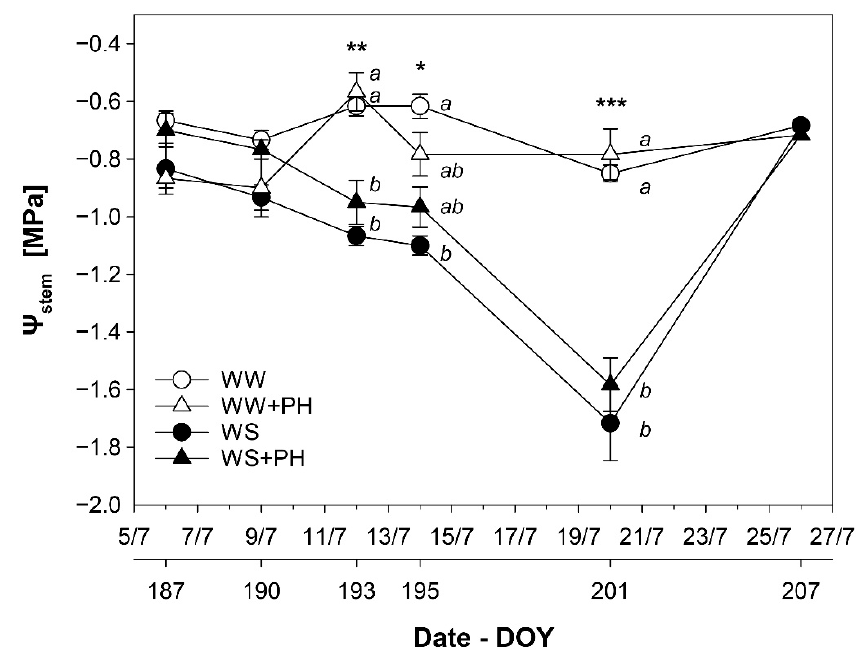
Figure 2. E ff ects of water stress (WS) compared with well-watered conditions (WW) and PH application, Figure 2. Effects of water stress (WS) compared with well-watered conditions (WW) and PH on stem water potential ( Ψ stem ) (MPa). Values are means ± SE ( n = 6), di ff erent letters indicate significant application, on stem water potential ( Ψ stem ) (MPa). Values are means ± SE ( n = 6), different letters di ff erences according to Tukey’s test ( p < 0.0083, p < 0.002 and p < 0.0008 after sequential Bonferroni indicate significant differences according to Tukey’s test ( p < 0.0083, p < 0.002 and p < 0.0008 after adjustment for α = 0.05 (*), α = 0.01 (**) and α = 0.005 (***), sequential Bonferroni adjustment for α = 0.05 (*), α = 0.01 (**) and α = 0.005 (***), respectively).